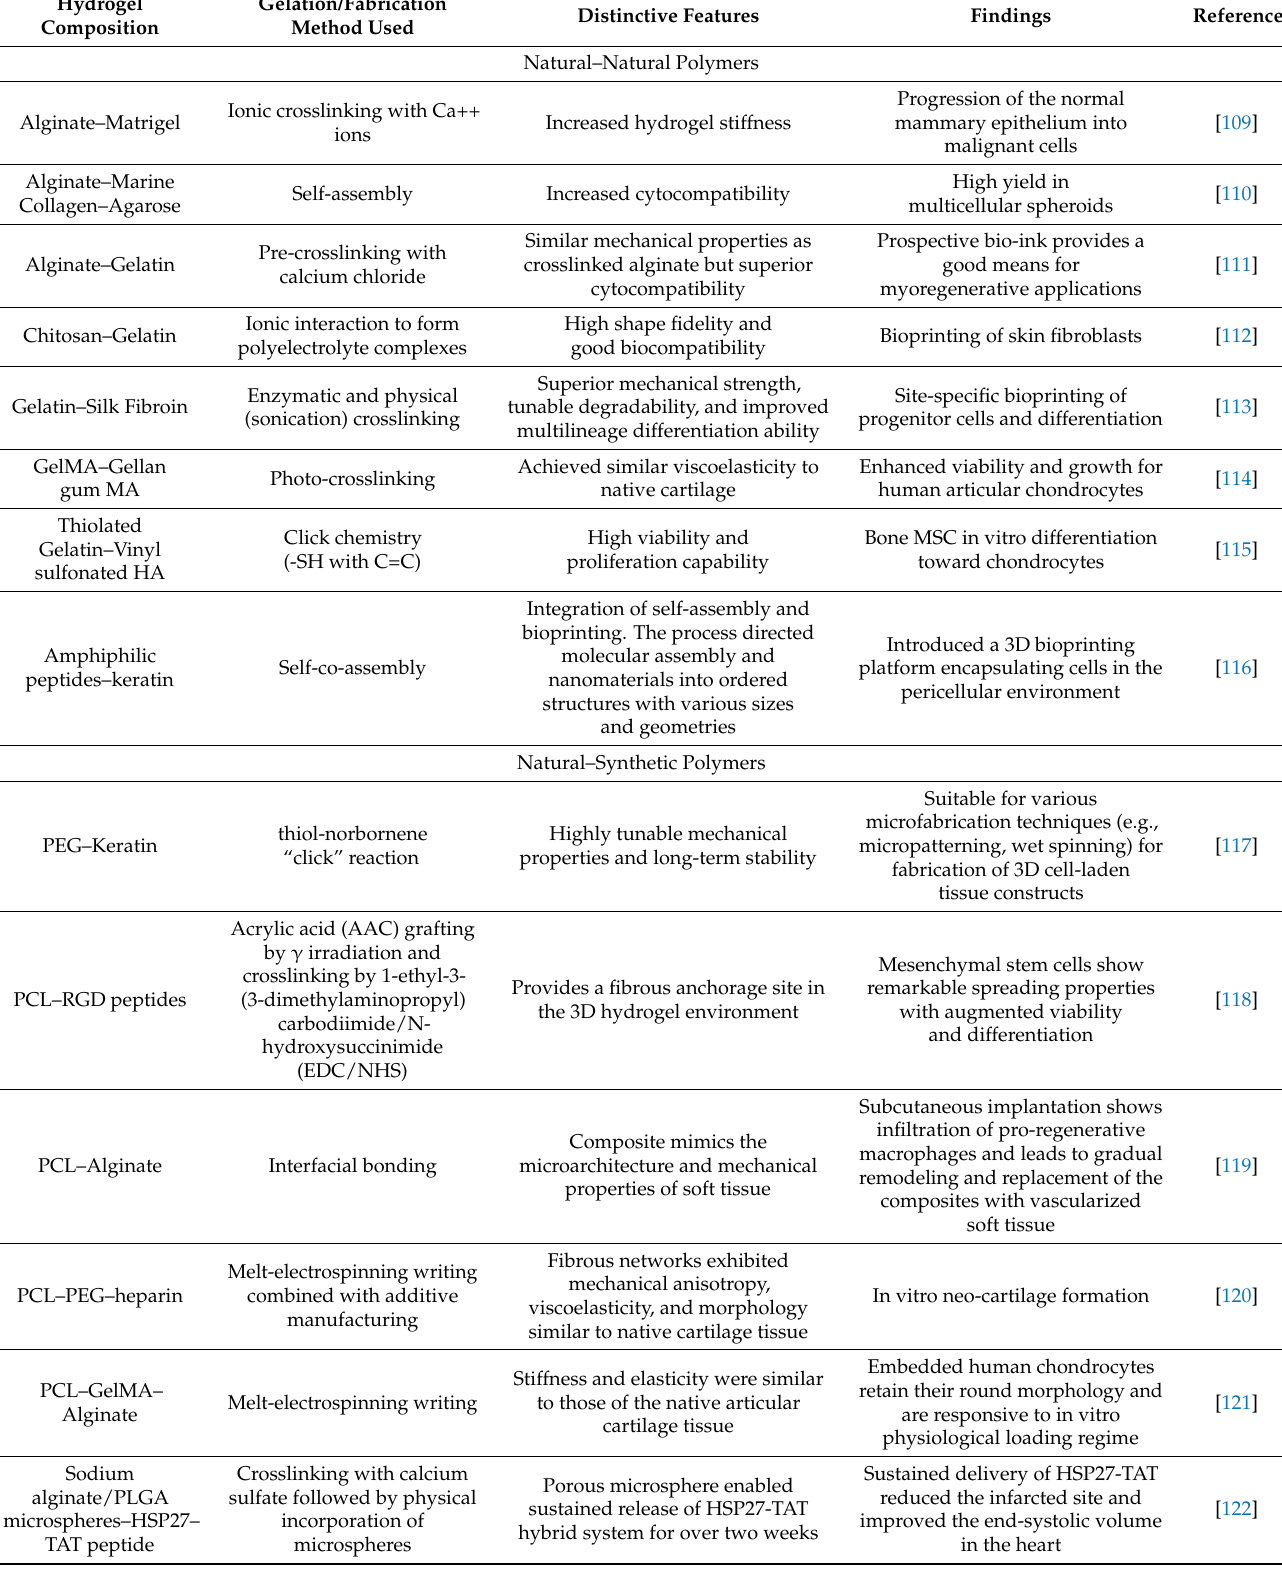
Table 2. Survey of hybrid hydrogel composition for in vitro 3D cell